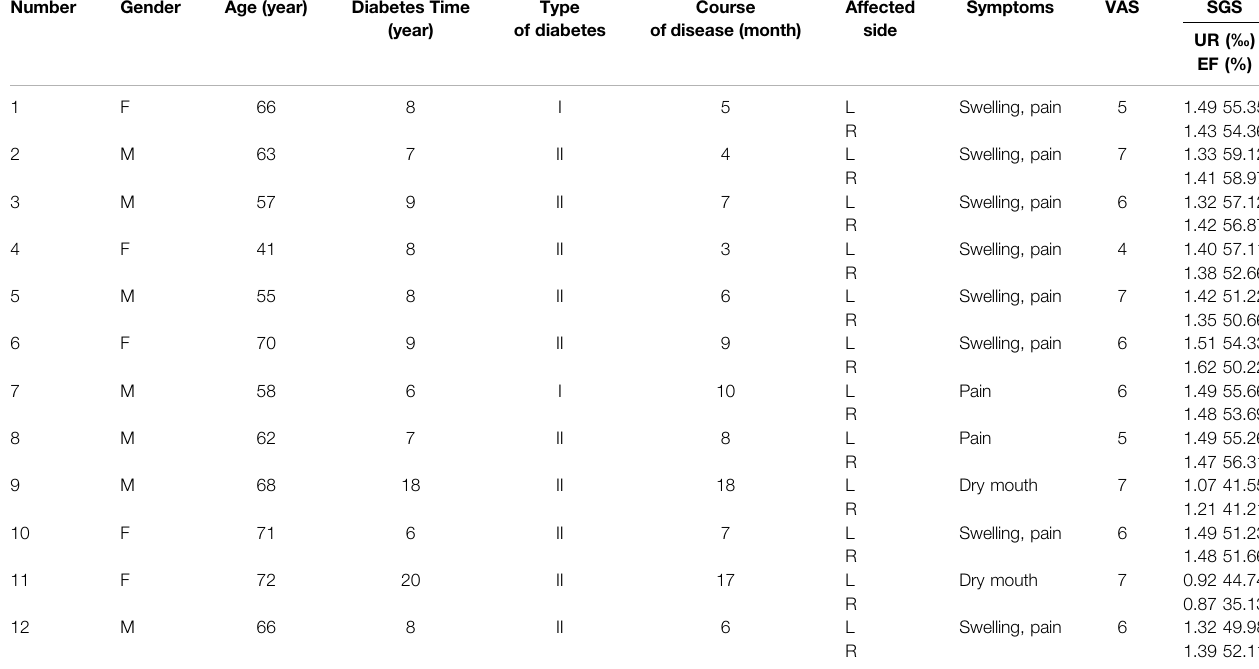
TABLE 1 | Characteristics of